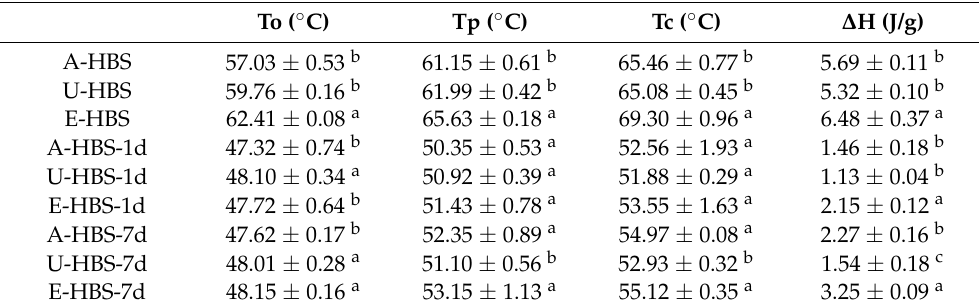
Figure 5. Differential scanning calorimetry (DSC) curves of A-HBS ( A ), U-HBS ( B ), E-HBS ( C ). A-HBS: HBS extracted by alkali method; U-HBS: HBS extracted by ultrasonic method; E-HBS: HBS extracted by enzymatic method. Table 3. Thermal properties of highland barley starch samples.